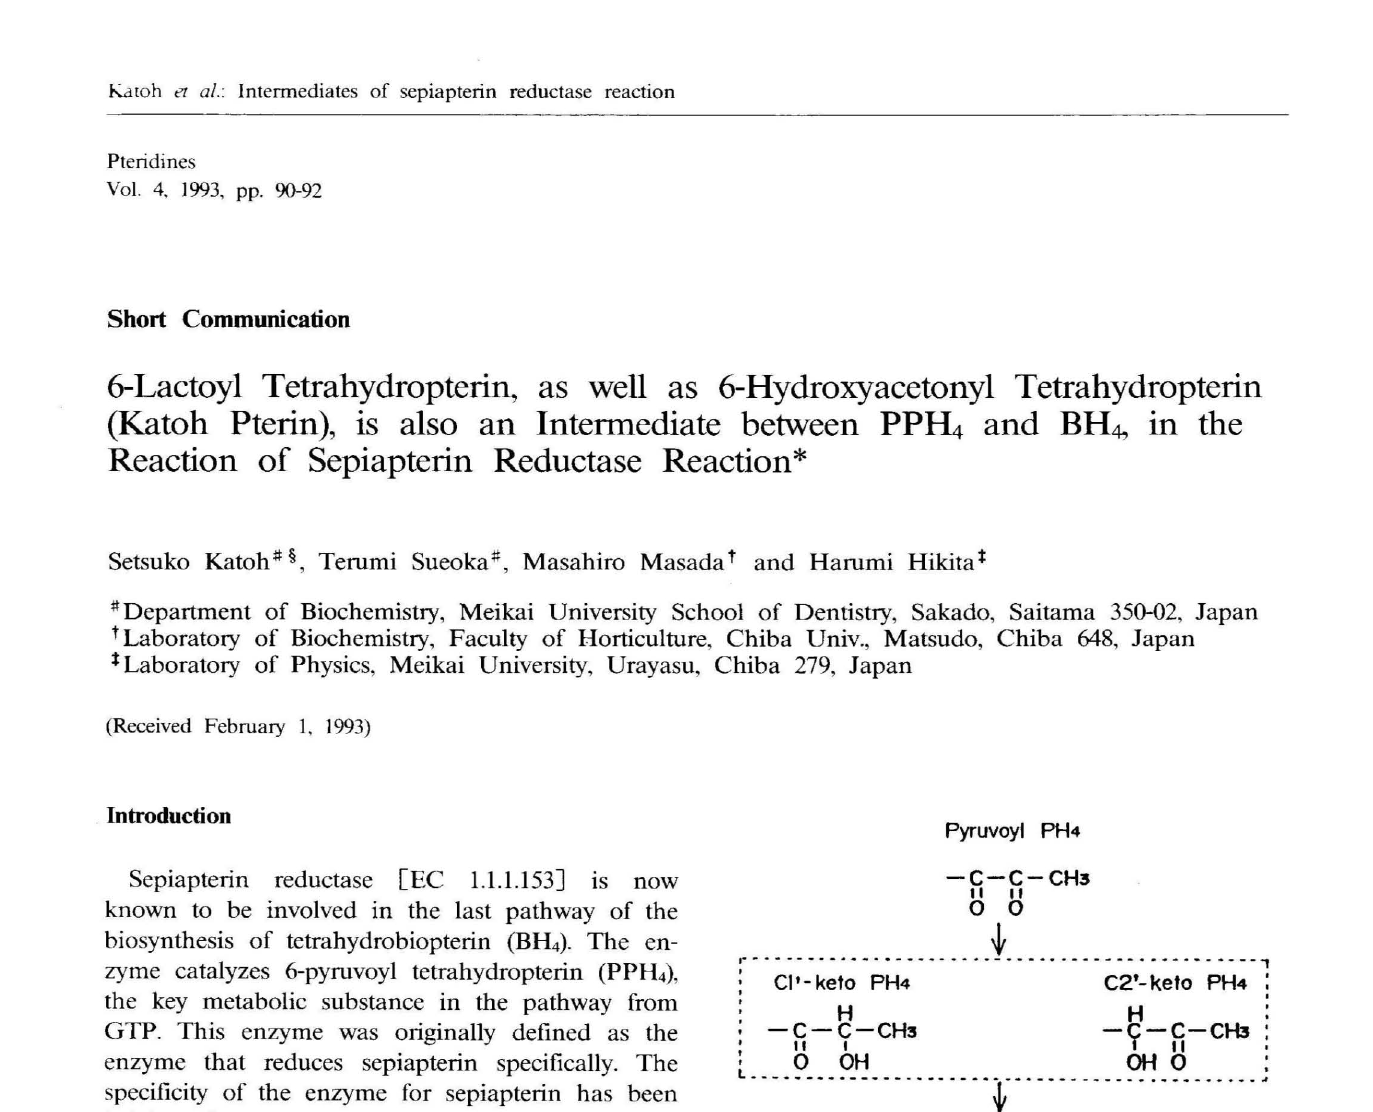
Figure I. Reduction of PPH4 by sepiapterin reductase. Con version into BH4 through